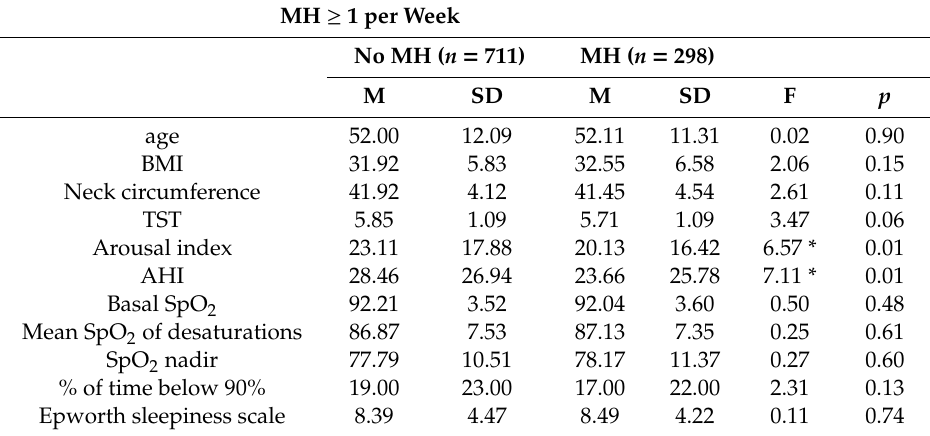
Table 1. Summary of the clinical and sleep study